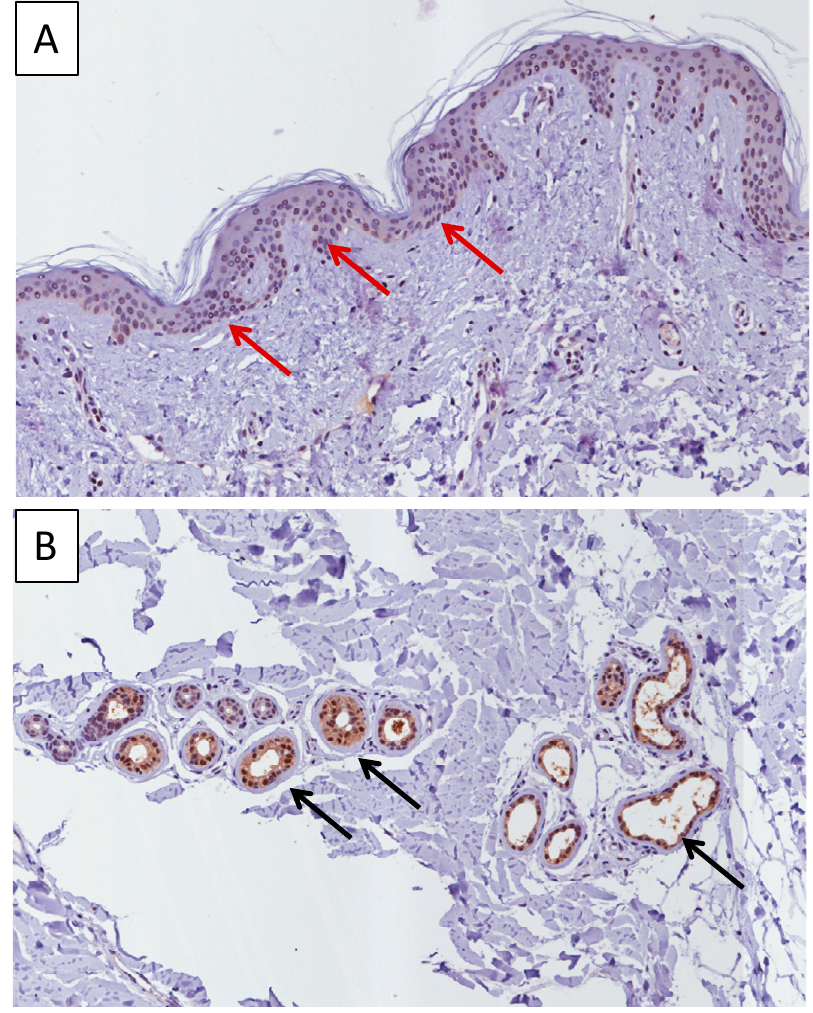
Figure 1. Immunohistochemistry analysis of MIF expression in normal skin biopsies. High levels of MIF can be detected at the basal layer of the epidermis (red arrow) ( A ) and in the cutaneous ap- pendages (eccrine glands and sebocytes) (black arrow) ( B ). Immunohistochemistry-positive staining was defined as the presence of brown chromogen detection within the cytoplasm. Representative microphotographs are shown.